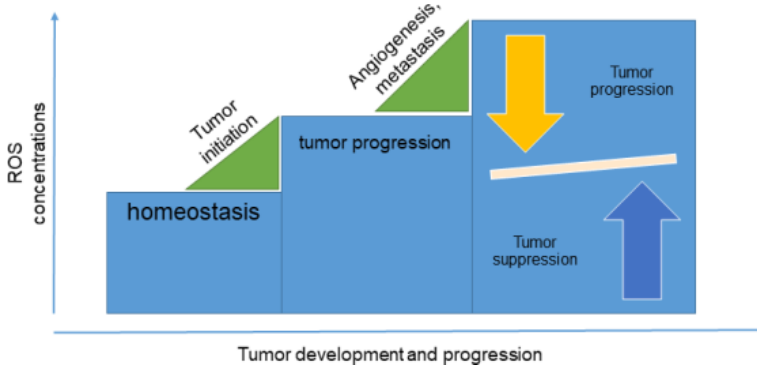
Figure 2. Reactive oxygen species (ROS) in tumor development.